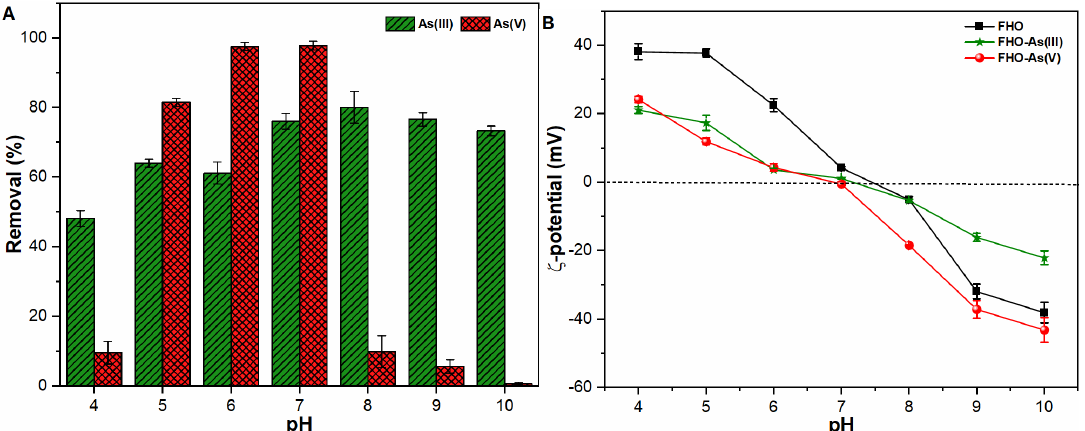
Figure 1. ( A ) Removal of As (III–V) species from water and ( B ) ζ -potential of FHO precipitates across a pH range of 4–10, temperature of 25 °C, FC dosage of 0.1 m mol/L and initial As loading of 1000 µg/L.